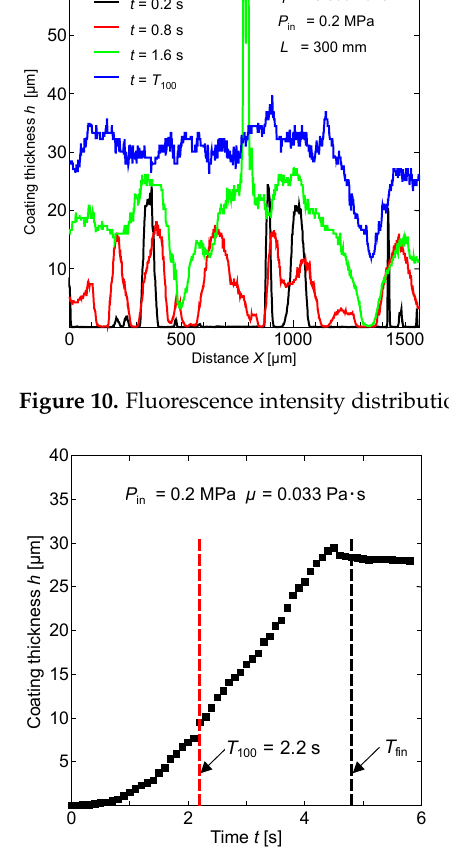
Figure 11. Evolution of the coating thickness over time.